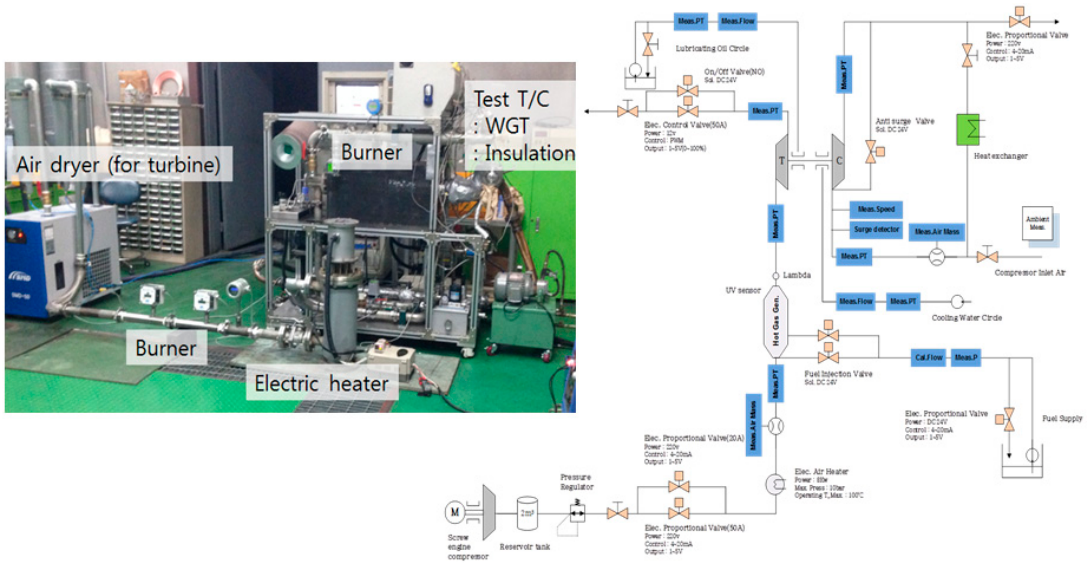
Figure 1. Schematic diagram and a picture of the laboratory test bench.